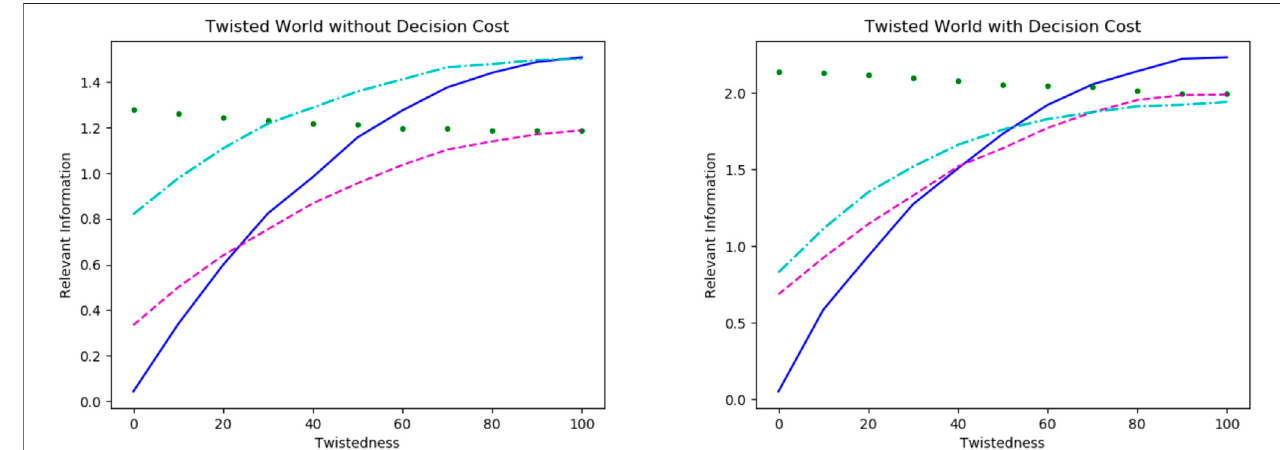
FIGURE 3 | Relevant information depending on the twistedness of the world for the different goal setups: Border Goal in blue (line), Central State in green (dotted), Center Line in cyan (dash-dotted) and Corner State in magenta (dashed). Note, the scale for the value of relevant information is different in both plots.